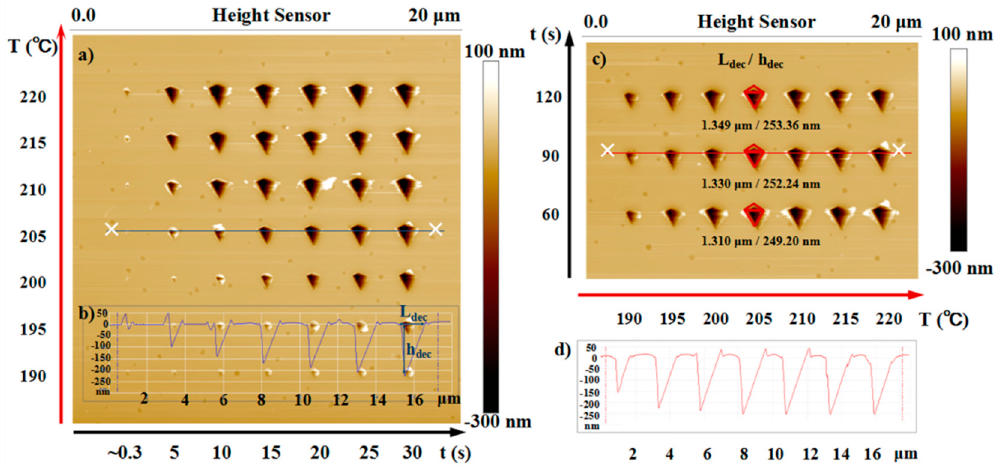
Figure 2. ( a ) AFM topographic image of the pyramid air gap structures on the film surface formed by using a heated tip to induce localized PPA decomposition. The corresponding tip temperatures (190–220 °C) and heating duration (0.3–30 s) for each experimental air gap are shown in the left and bottom side of the image, respectively. ( b ) The cross-section plot of the position marked in (a) by a blue line. The method for measuring the feature sizes ( L dec and h dec ) of the air gap structures is shown in the right-side structure section. ( c ) AFM imaging plot of the pyramid air gap structures formed under the condition of the heating duration of 60–120 s and the tip temperature of 190–220 °C. For the tip temperature of 205 °C, the values of the two feature sizes of the structures are given, close below the corresponding structure. ( d ) The cross-section plot of the position marked in (c) by a red line.